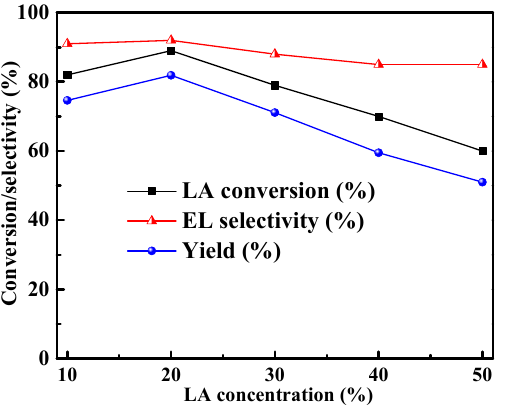
Figure 4. Effect of LA concentration concerning EL selectivity over Pt/STA-ZrO 2 catalyst.